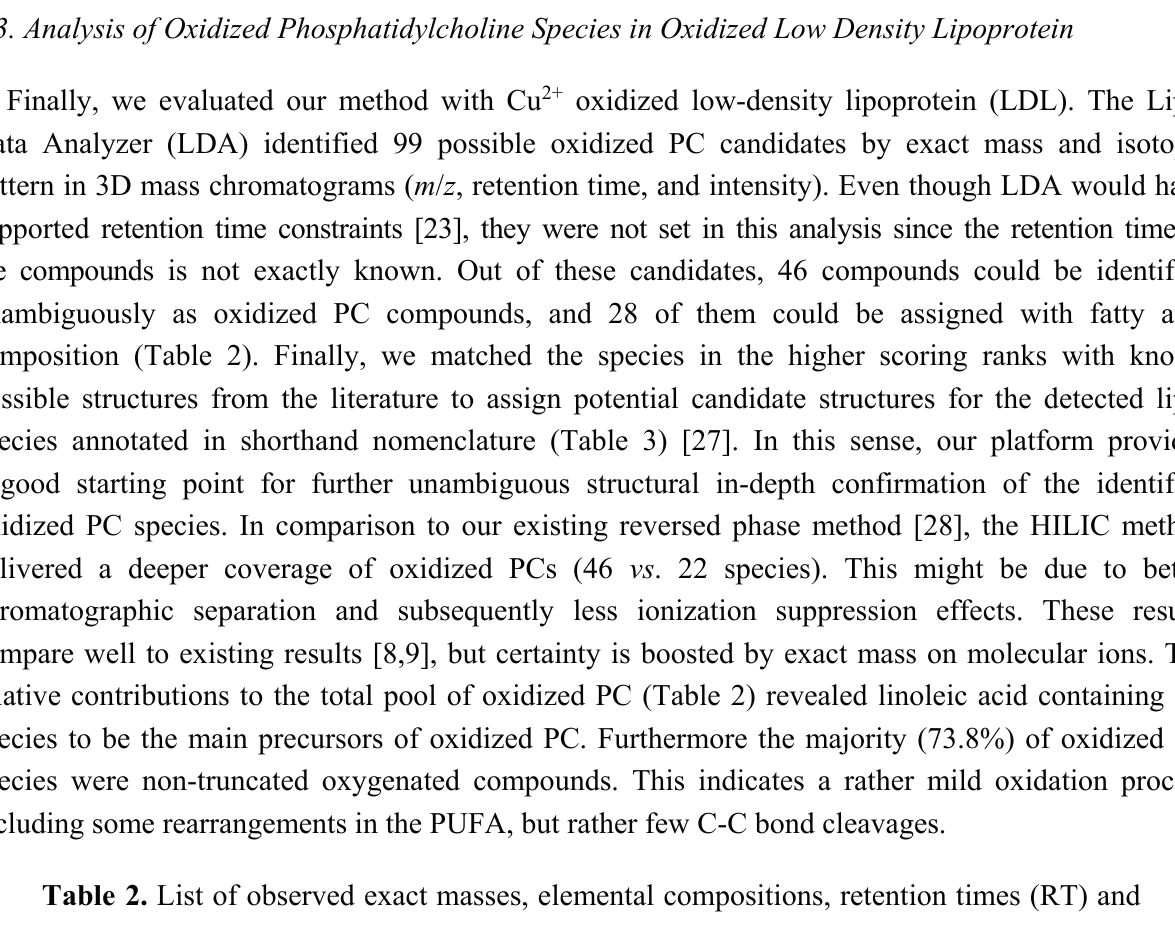
Table 2. List of observed exact masses, elemental compositions, retention times (RT) and corresponding compound assignments by shorthand nomenclature in oxidized LDL.